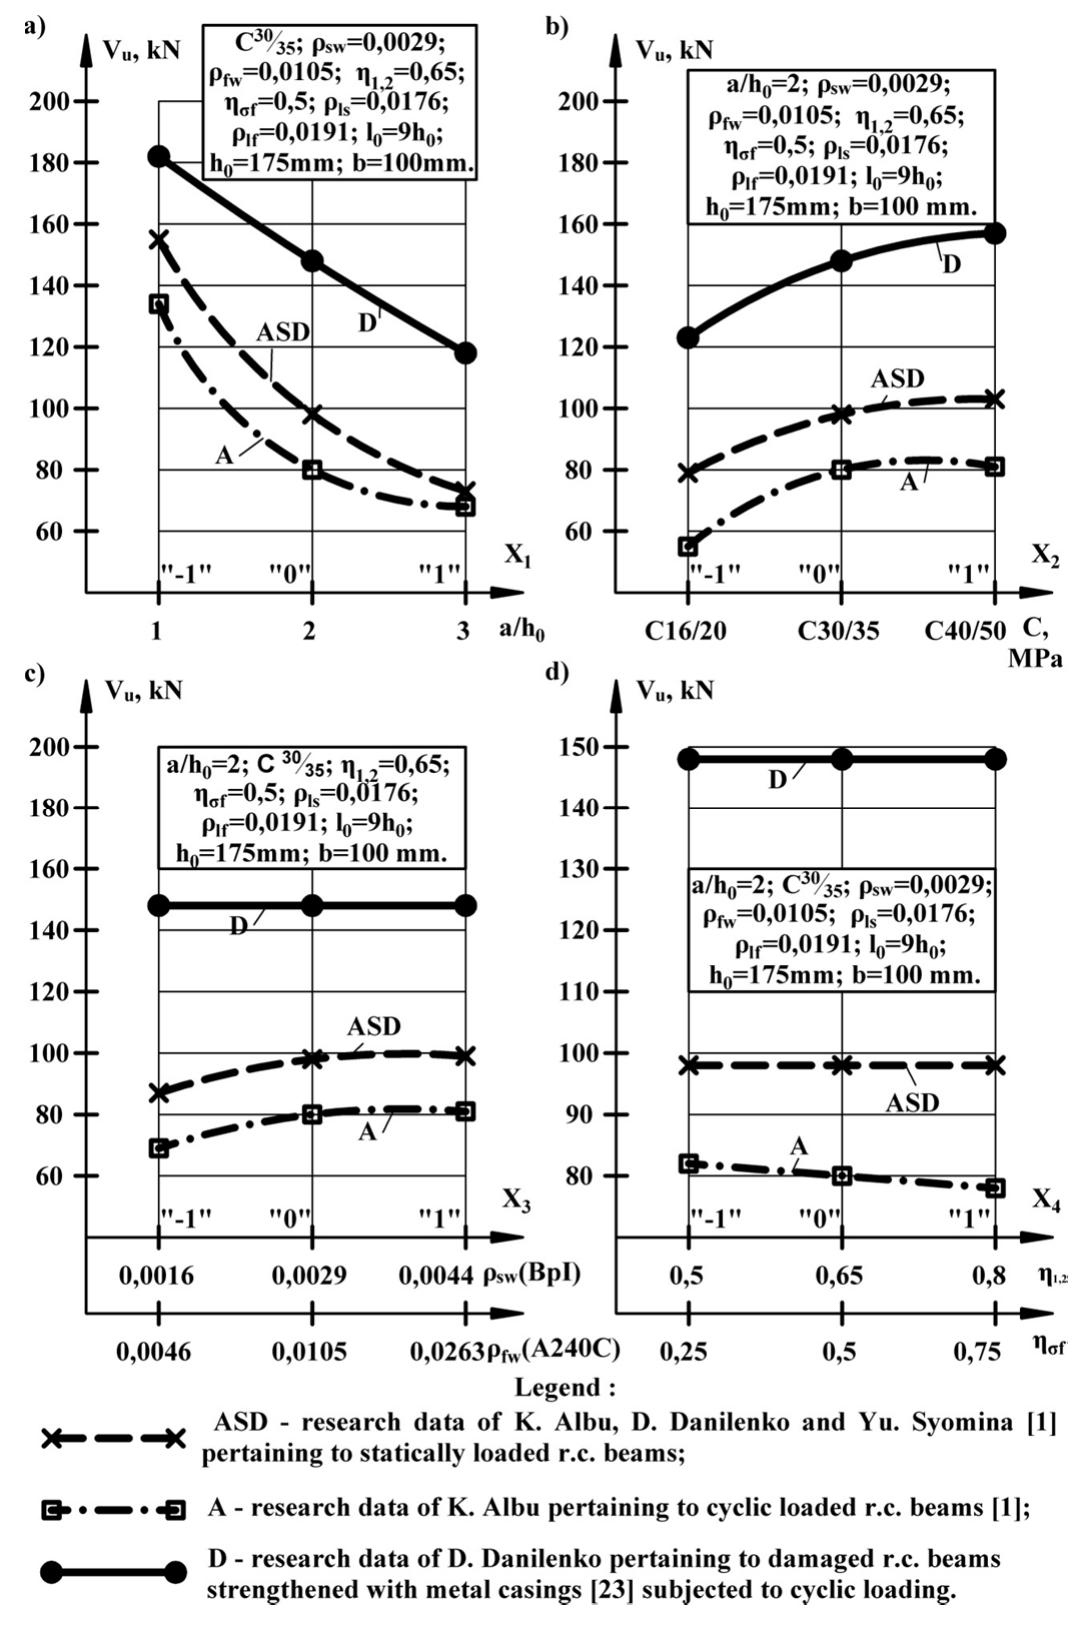
Figure 1. Impact of the relative shear span (a), concrete grade (b) and quantity of the transverse reinforcement (c) and levels of the transverse loading and previous stress in the metal casings (d) on the load-bearing capacity of the test element support areas before their